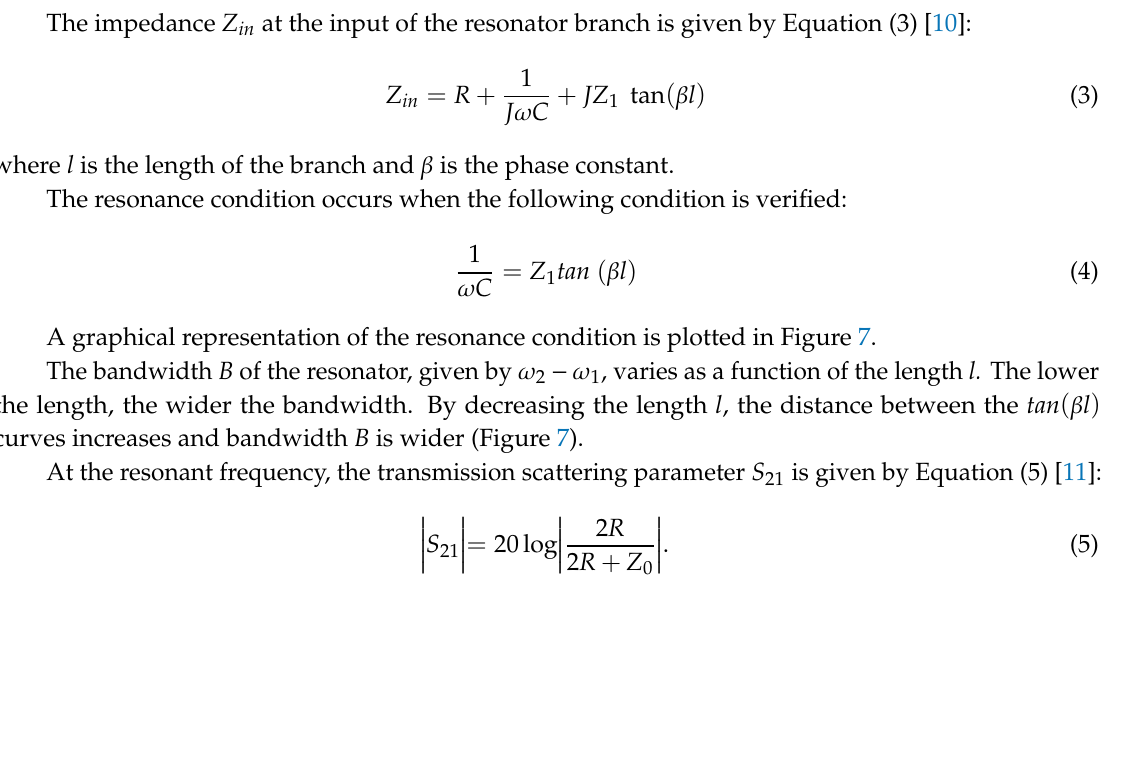
Figure 7. Graphical determination of the resonant frequency for a coaxial resonator with a branch length l .